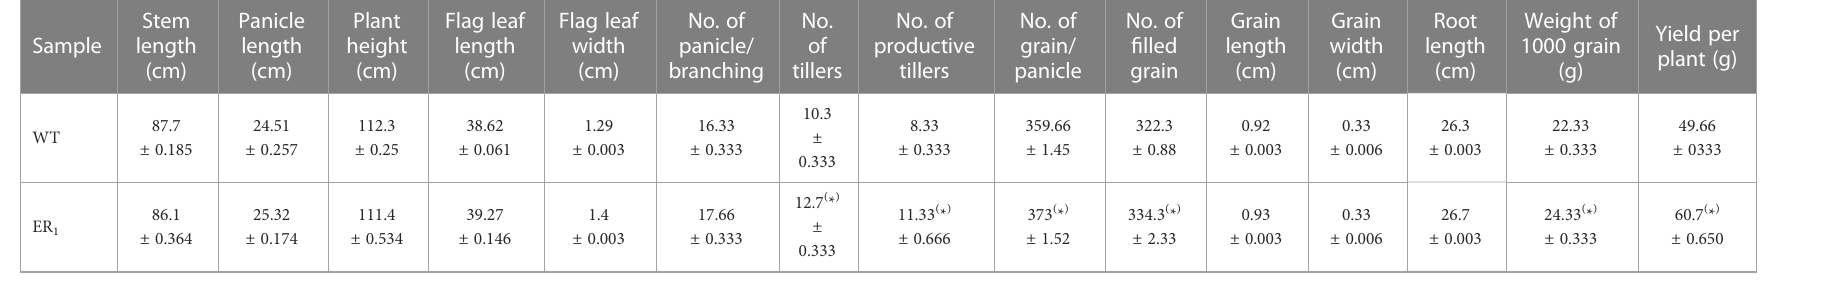
TABLE 1 (B) Agronomic traits performances analyses of WT and edited plants under fi eld